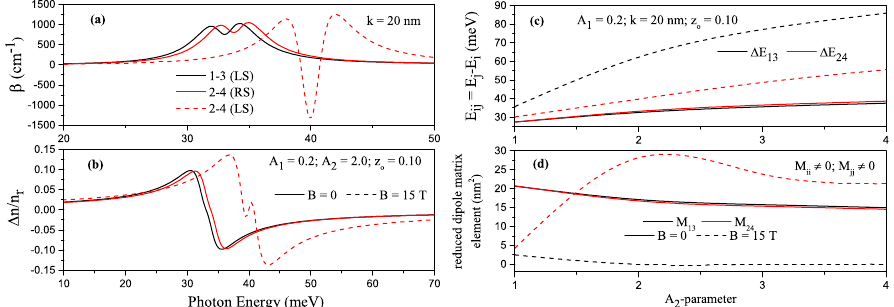
Figure 6. For some transitions between the energy levels in harmonic-Gaussian asymmetric DQW with z 0 = 0.10, A 1 = 0.2, and A 2 = 2.0, the variation of total absorption coefficients as a function of the incident photon energy ( a ), the variation of total refractive index as a function of the incident photon energy ( b ). According to the parameter- A 2 , the variation of the energy difference between related levels ( c ) and the variation of reduced dipole matrix element ( d ), where black/red lines are for (1–3)/(2–4) transitions. Solid (dashed) lines are for B = 0 ( B = 15T). For some transitions between the energy levels in H-G ADQW with z 0 = 0.25, A 1 = 0.2, and A 2 = 2.0, the variations of TAC and RIC as a function of the incident photon energy are given in Figures 7a and 7b, respectively. Solid (dashed) lines are for B = 0 ( B = 15 T). As the asymmetry of the structure increases, the fourth and sixth level electrons are localized in the right well when there is no magnetic field, while the fifth level electron is completely localized in the right well, and the electron in the sixth level is more localized in the left well, although it is localized in both wells. The peaks of TACs and RICs corresponding to the (1–2) and (2–3) transitions shift towards the higher photon energies (blue shift), a minimum in the TAC occurs, and a small increase in the RIC for the (2–3) transition is observed since the non-linear term becomes dominant; this is